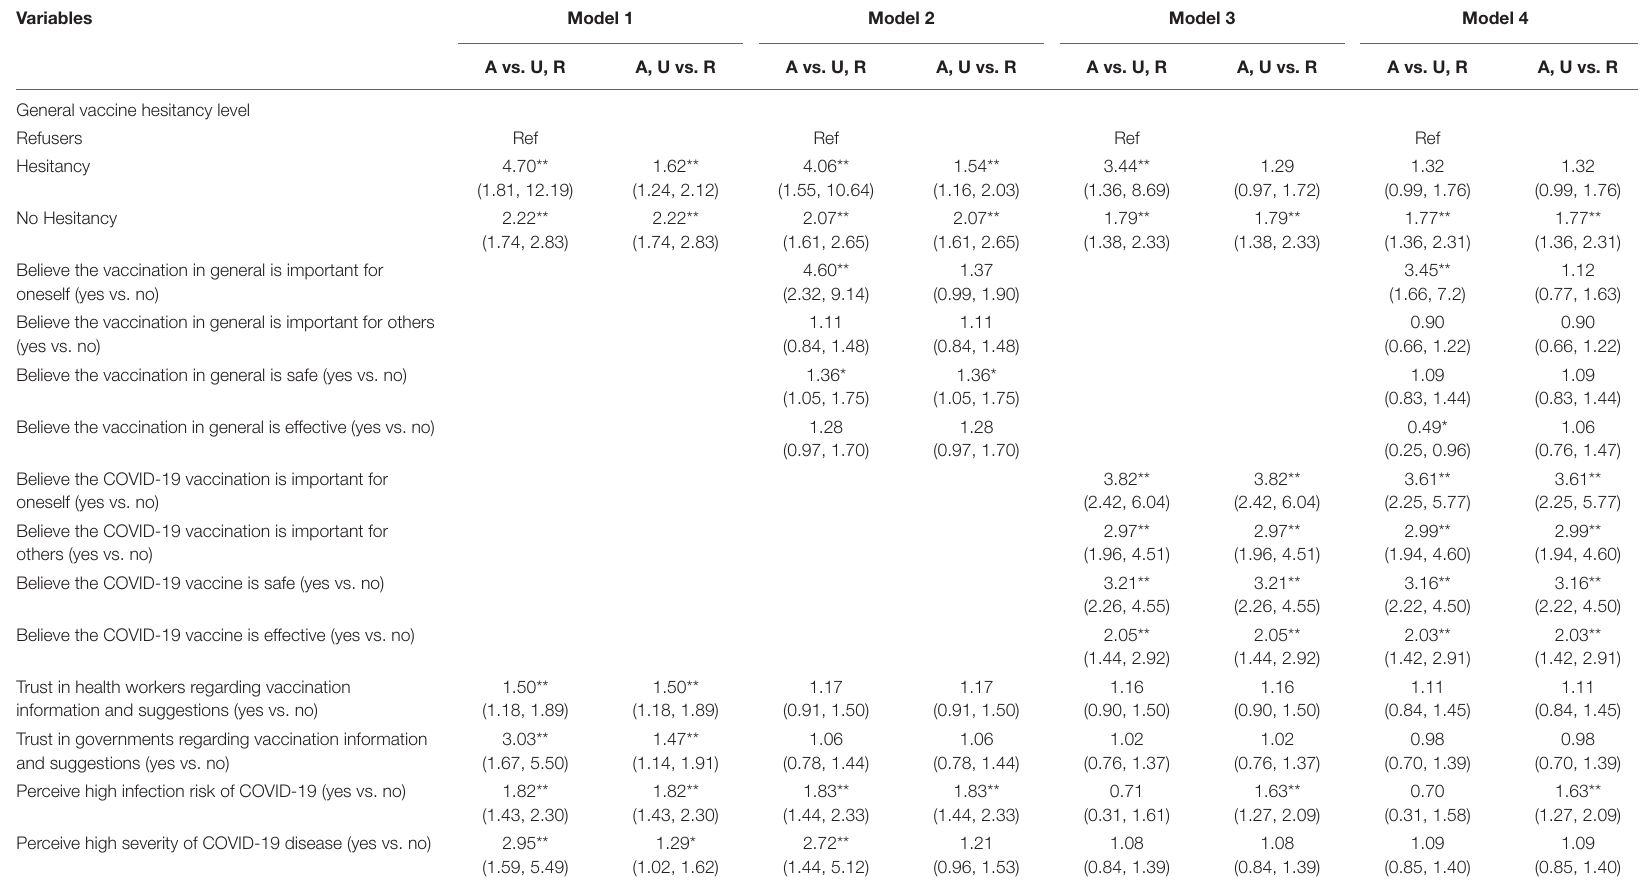
TABLE 3 | Association of general vaccination attitudes and perceptions on the acceptance of the newly-developed COVID-19 vaccine by generalized order logistic regressions.